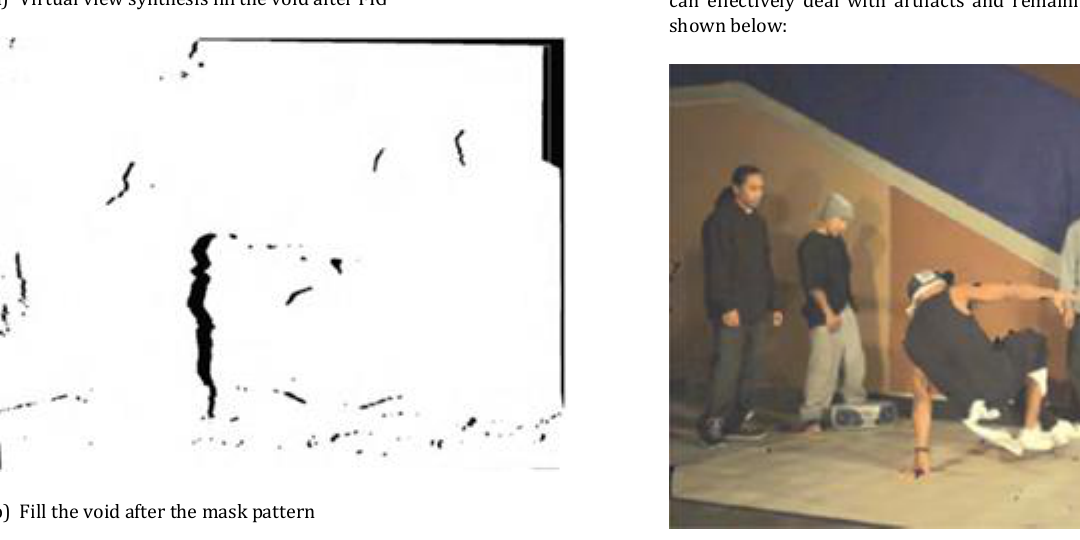
Figure 4: Fill the void after the